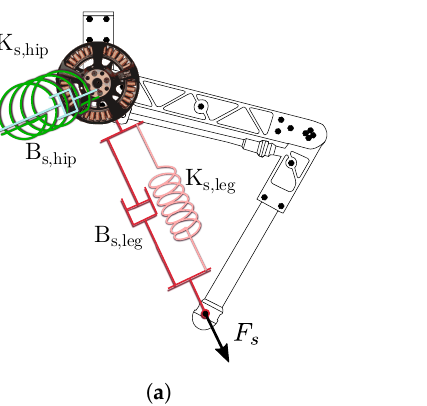
Figure 4. Illustration of the hip compliance ( K s,hip , B s,hip ) and foot compliance ( K s,leg , B s,leg ) in a robot leg ( a ) and of the simplified impedance loop in relation to external force θ m − and ( b ) is derived and simplified from Figure